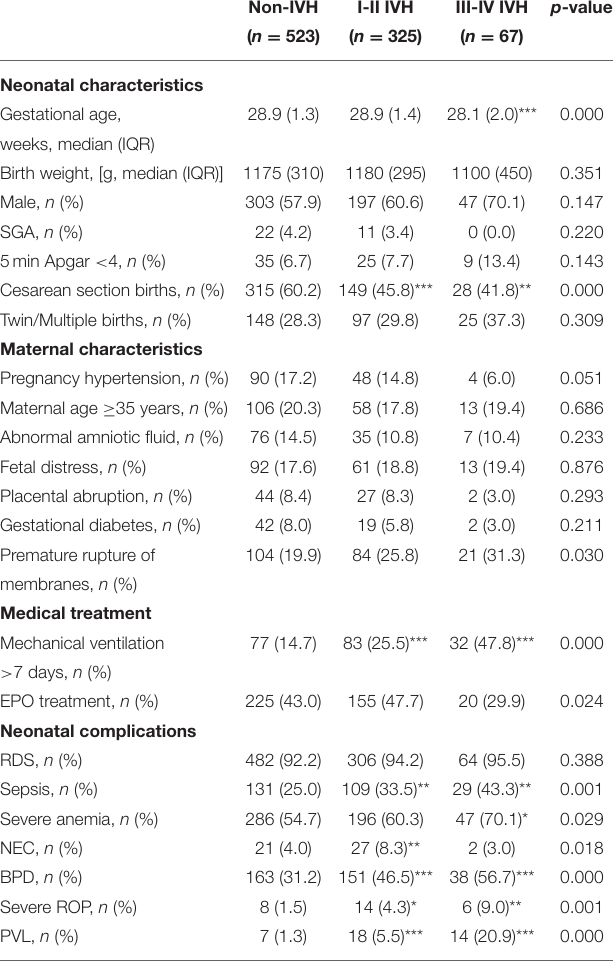
TABLE 1 | Clinical characteristics of 915 preterm infants.